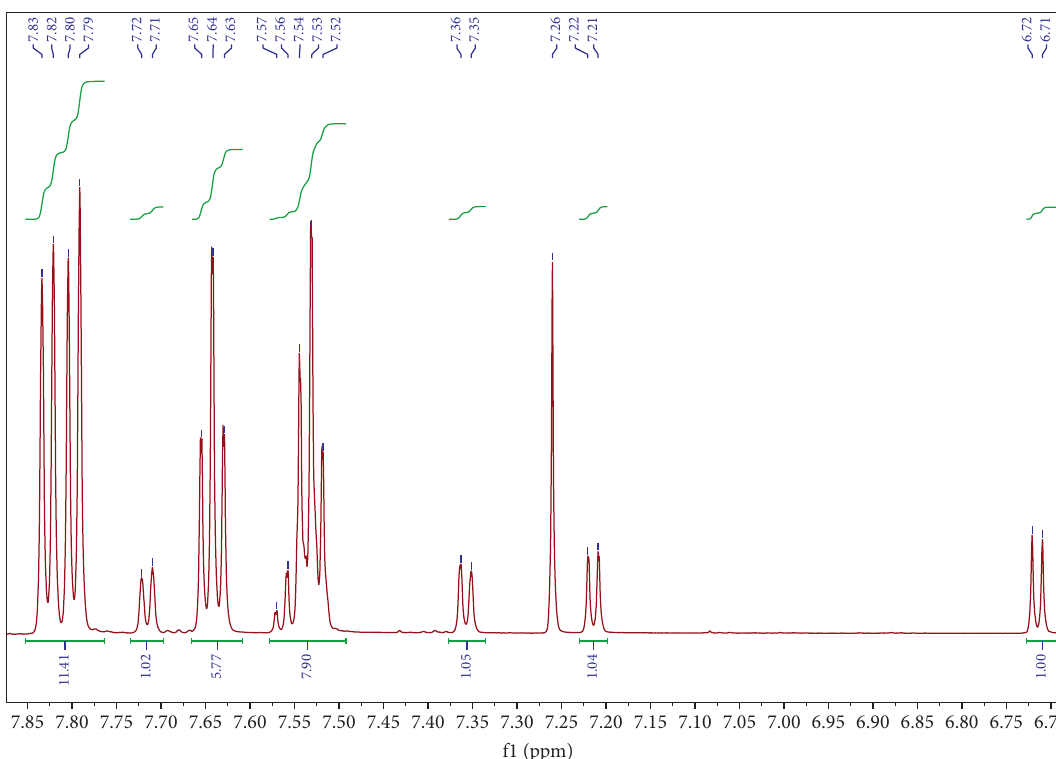
Figure 8: 1 H NMR of the precipitate from mixture 8 (n-butyl sulfide/benzothiophene/dibenzothiophene) in CDCl dibenzothiophene sulfone and benzothiophene sulfone, at a ratio of approximately 3:1.